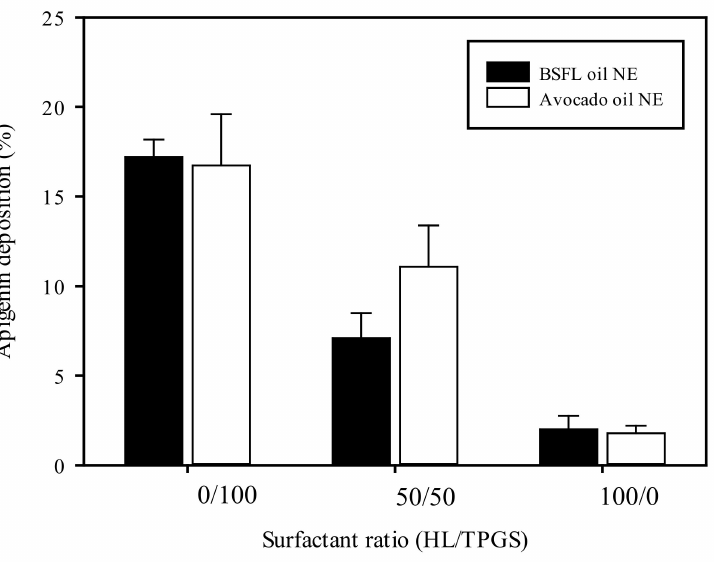
Figure 5. Artificial skin deposition of Apig loaded BSFL oil NEs and AV oil NEs with different surfactant ratios of HL/TPGS at SOR 60% and oil content